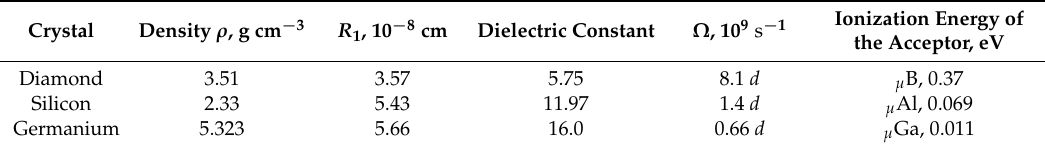
Table 1. Physical parameters of the C, Si and Ge crystals and the estimate of the frequency Ω .